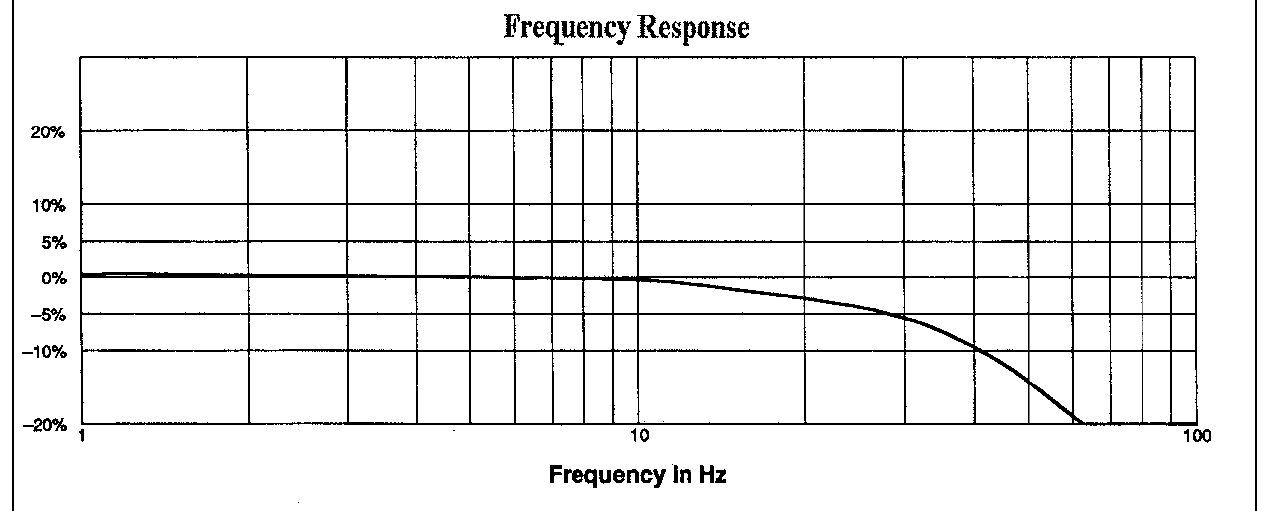
Figure 2. Calibration data (longitudinal accelerometer).